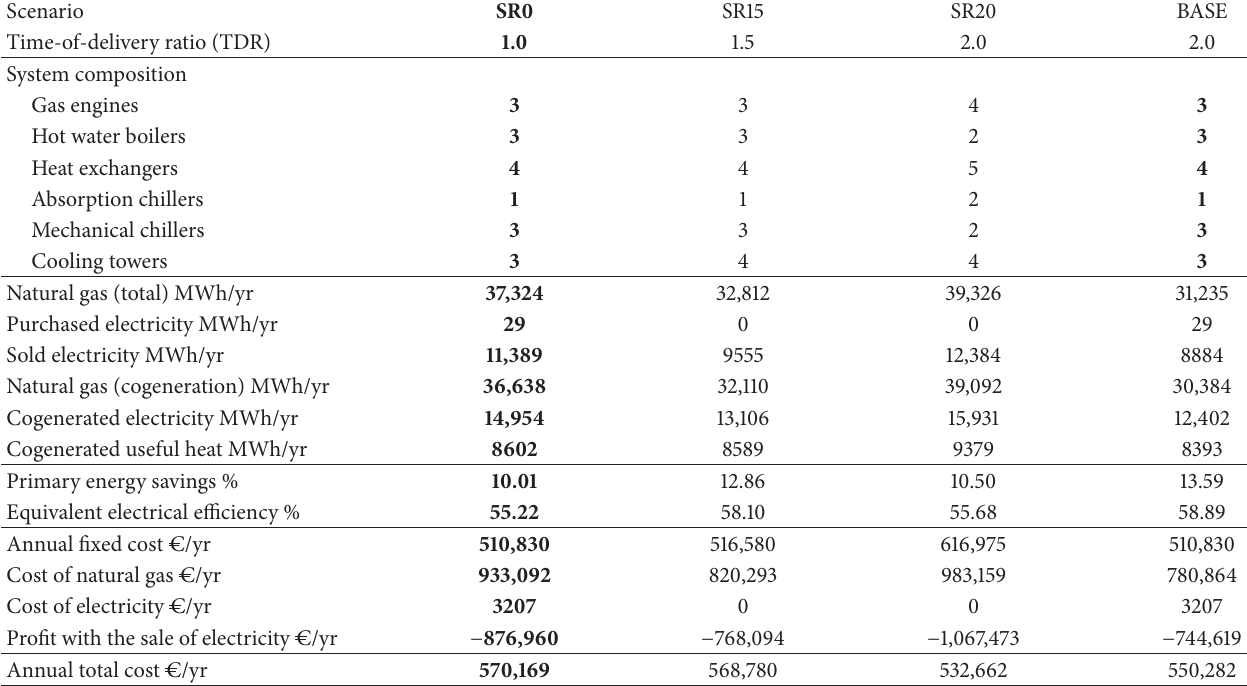
Table 10: Sensitivity analyses for hourly differentiation in the feed-in